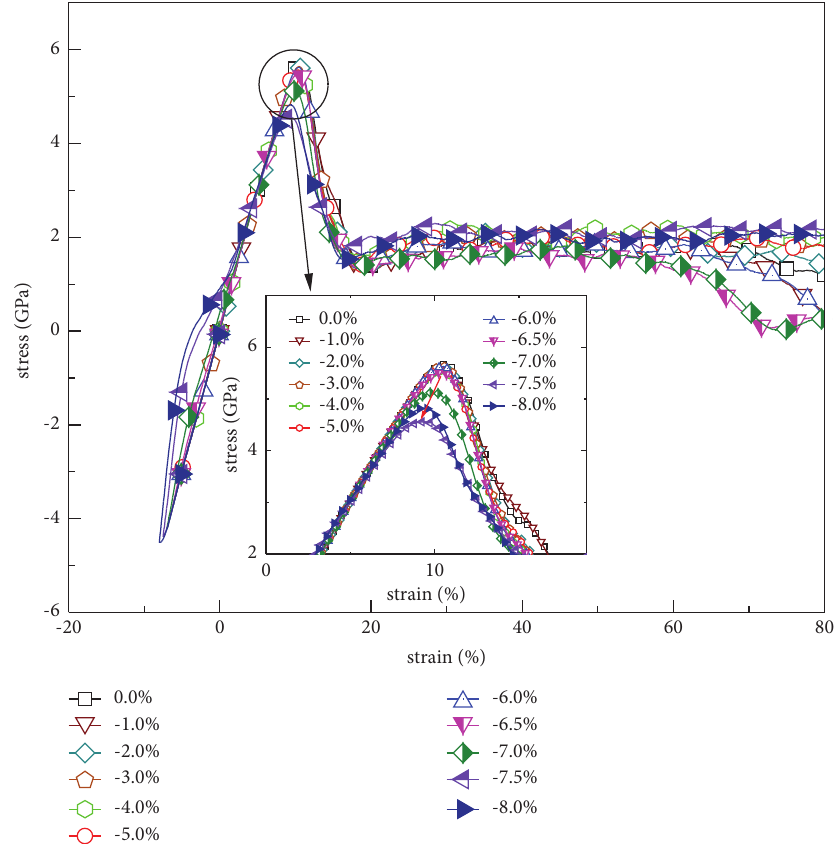
Figure 4: Stress-strain curves of different compressive strains (the inset is a partial enlarged view of the yield strength in the stress-strain curve).